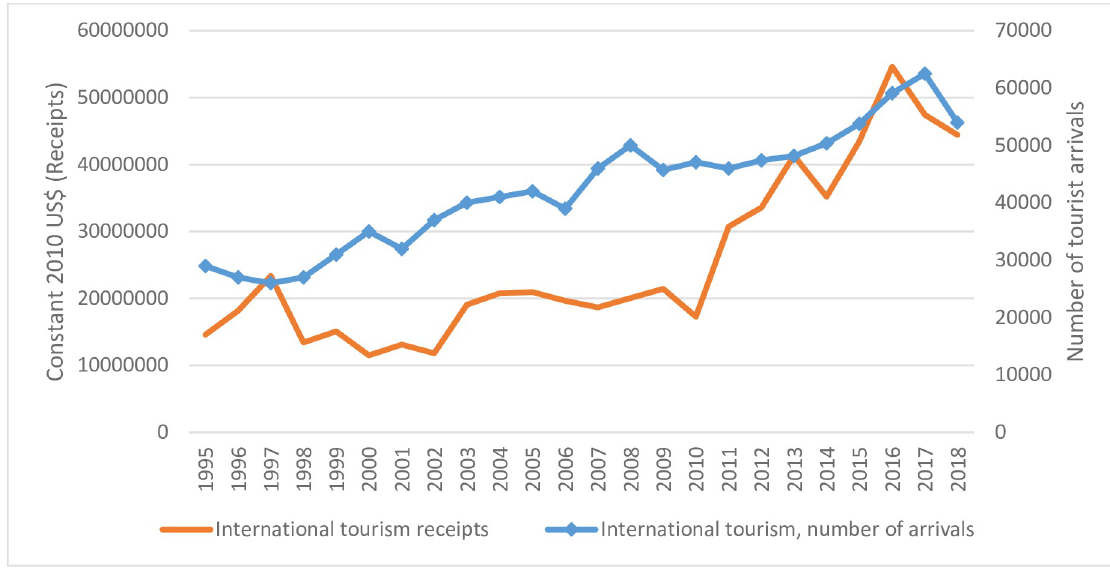
Fig 1. Tonga’s tourism sector performance—1995 to 2018. Data obtained from World Bank.